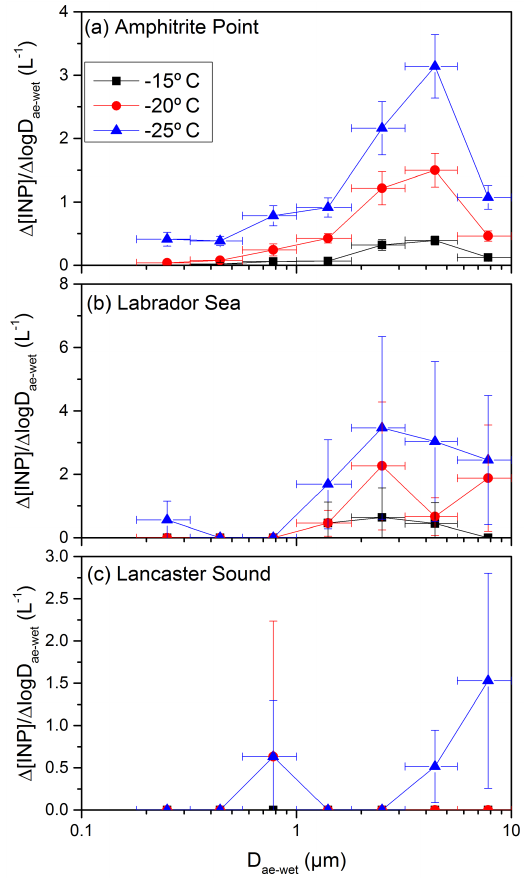
Figure 3. Average INP number concentrations at freezing temper- atures of − 15, − 20, and − 25 ◦ C as a function of aerodynamic di- ameter ( D ae ) for the three sites studied. The plotted x values rep- resent the midpoints of the size bins from the MOUDI. The x error bars represent the widths of the size bins from the MOUDI. For the Amphitrite Point samples, standard error of the mean was used to represent the uncertainty of INP concentrations during the month. At both Labrador Sea and Lancaster Sound, only one MOUDI sam- ple was collected, and we assume the monthly INP concentrations have the same normal distribution as the Amphitrite Point samples. Hence for the y error bars at these locations, we assume that the rel- ative standard deviations for supermicron and submicron particles were the same as the relative standard deviation for supermicron and submicron particles observed in the Amphitrite Point